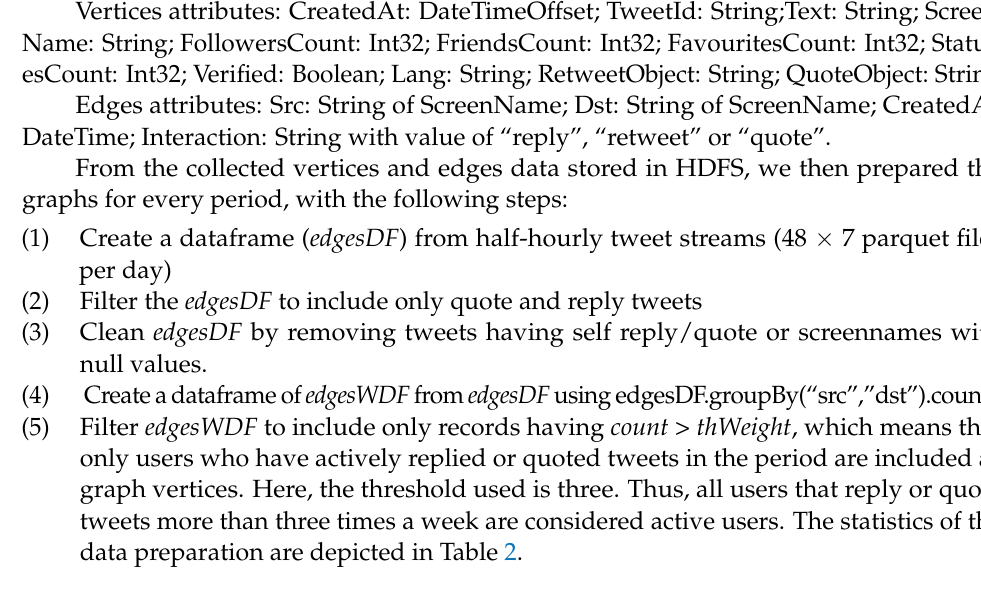
Table 2. Statistics of the raw and reduced (filtered) tweet datasets.